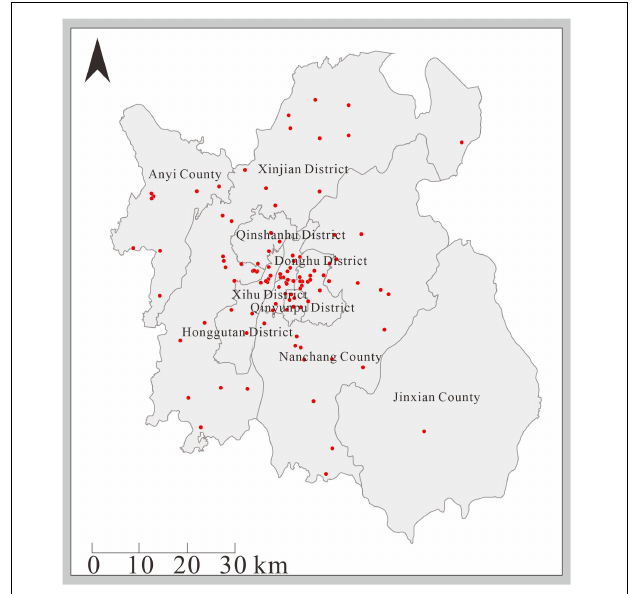
FIGURE 2 | Distribution of EV-A71 vaccination sites in Nanchang